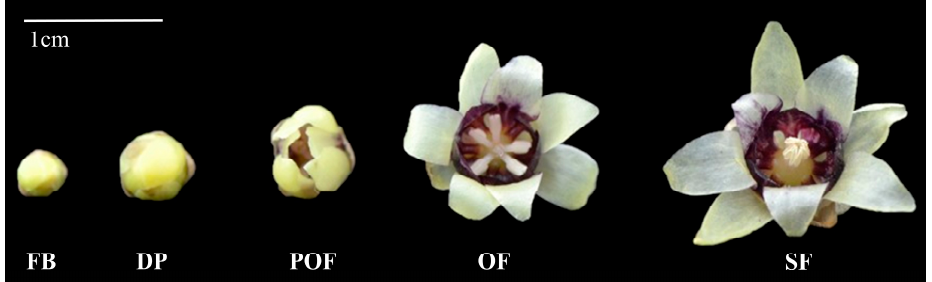
Figure 1. Developing stages of the flower of the Wintersweet ( Chimonanthus praecox ) H29 (Huazhong 29) genotype. Abbreviations: FB, flower bud; DP, display petal; POF, partially-open flower; OF, open flower stage; SF, senescing flower. Scale bar = 1 cm.